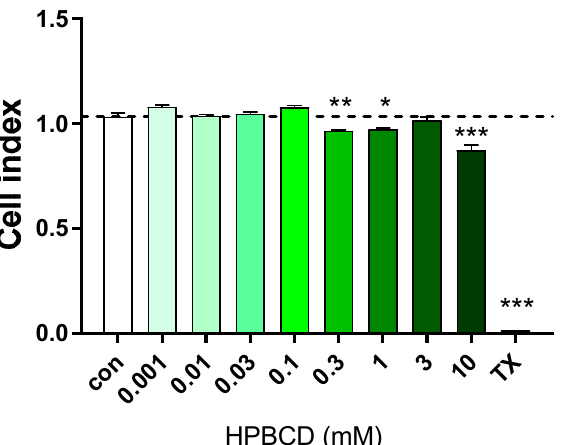
Figure 2. Effect of 2 h treatment with HPBCD on the viability of primary rat brain endothelial cells. Values presented are means ± SEM. Statistical analysis: one-way analysis of variance followed by Dunnett’s post-test. * p < 0.05, ** p < 0.01, *** p < 0.001 compared to control group, n = 6.